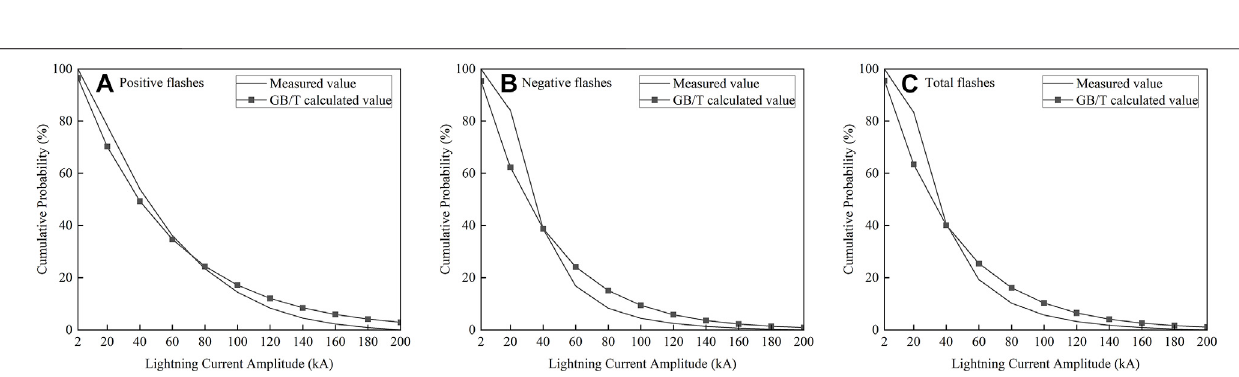
FIGURE 4 | Fitting curves based on measured values and calculated values by the IEEE (A) Positive fl ashes, (B) Negative fl ashes, and (C) Total fl ashes.